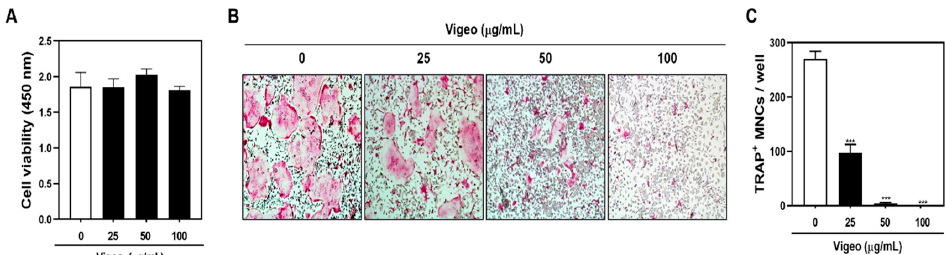
Figure 3. Vigeo attenuates receptor activator of nuclear factor-B ligand (RANKL)-induced osteoclast differentiation without cytotoxicity. ( A ) Bone marrow macrophages (BMMs) were cultured with 30 ng/mL M-CSF and the indicated concentration of Vigeo for 3 days. Cell viability of Sec was evaluated using the XTT assay by measuring absorbance at 450 nm. ( B ) BMMs were seeded with M-CSF (30 ng/mL) and stimulated with RANKL (100 ng/mL) and the indicated concentrations of Vigeo for 3 days. TRAP staining was performed to assess osteoclast formation and representative images were captured. ( C ) TRAP-positive multinucleated cells counted as osteoclasts (nuclei > 5). *** p < 0.001 versus the control group.